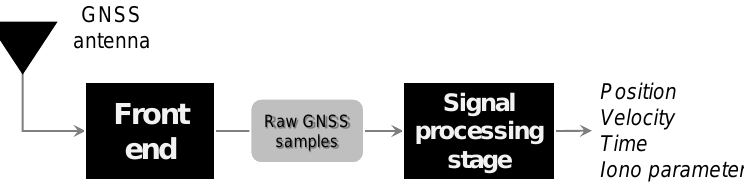
Figure 2. Generic architecture of a Software Defined Radio (SDR) satellite navigation